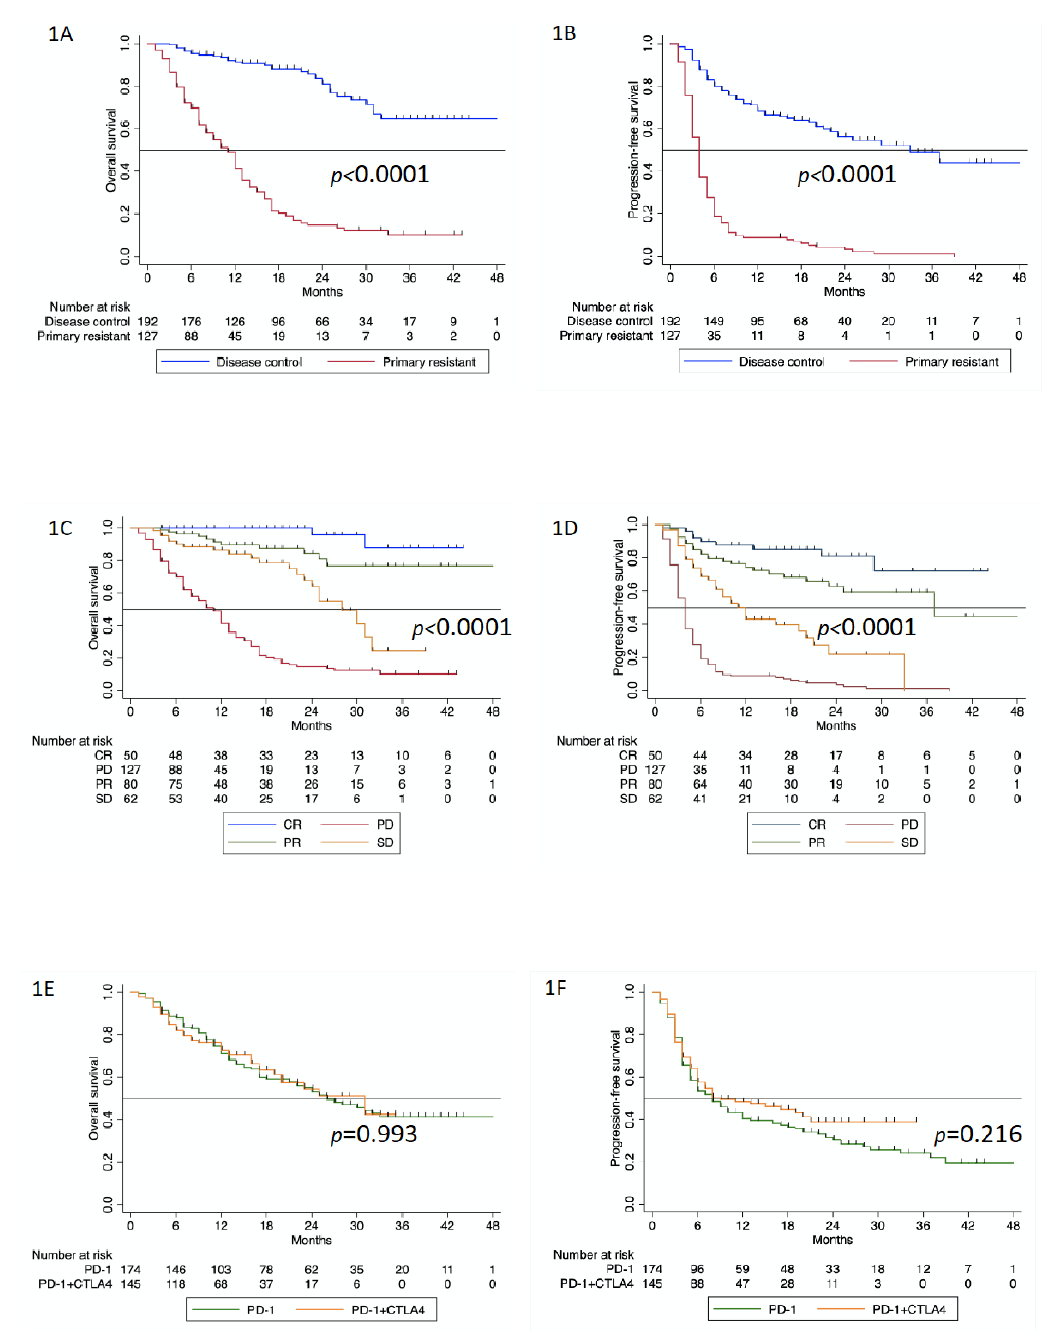
Figure 1. ( A ). Overall survival according to response to first-line PD-1-based immunotherapy ( p